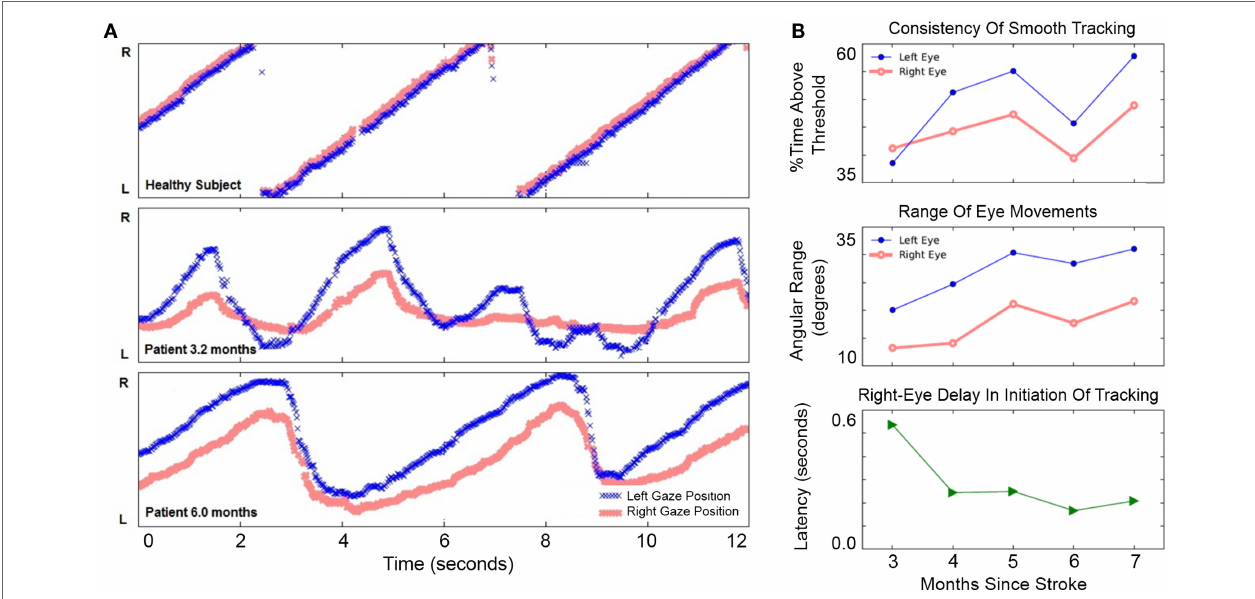
FIGURe 3 | Improvement of horizontal eye movements during left-to-right smooth pursuit . (a) Horizontal gaze position during 12 s of left-to-right smooth pursuit interspersed with reverse saccades. The Y -axis in gaze position recordings spans 46° of the horizontal visual field. Top: representative horizontal gaze position in a healthy pilot subject. Middle: representative sample from session completed 3.2 months after hemorrhage when eye movements were not conjugate and saccades were slower than a healthy subject’s (compare with top panel). The right eye’s range of horizontal movement relative to the left eye was limited; the right eye initiated smooth rightward movement with a delay relative to the left eye. Bottom: representative sample from session completed 6 months after hemorrhage. Eye movements were more conjugate. Both eyes were able to perform longer sweeps of smooth pursuit and more-rapid reverse saccades. (B) Improvement of voluntary eye movements. Top: consistency of left eye movements (blue filled circles) may have improved more than right-eye movements (red open circles), although neither trend was significant (see text). Middle: range-of-movement was greater for the left eye than the right eye at 3 months. The range-of-movement of both eyes improved significantly from 3 to 7 months. Bottom: right-eye delay in initiation of rightward tracking was present at 3 months but improved significantly by 7